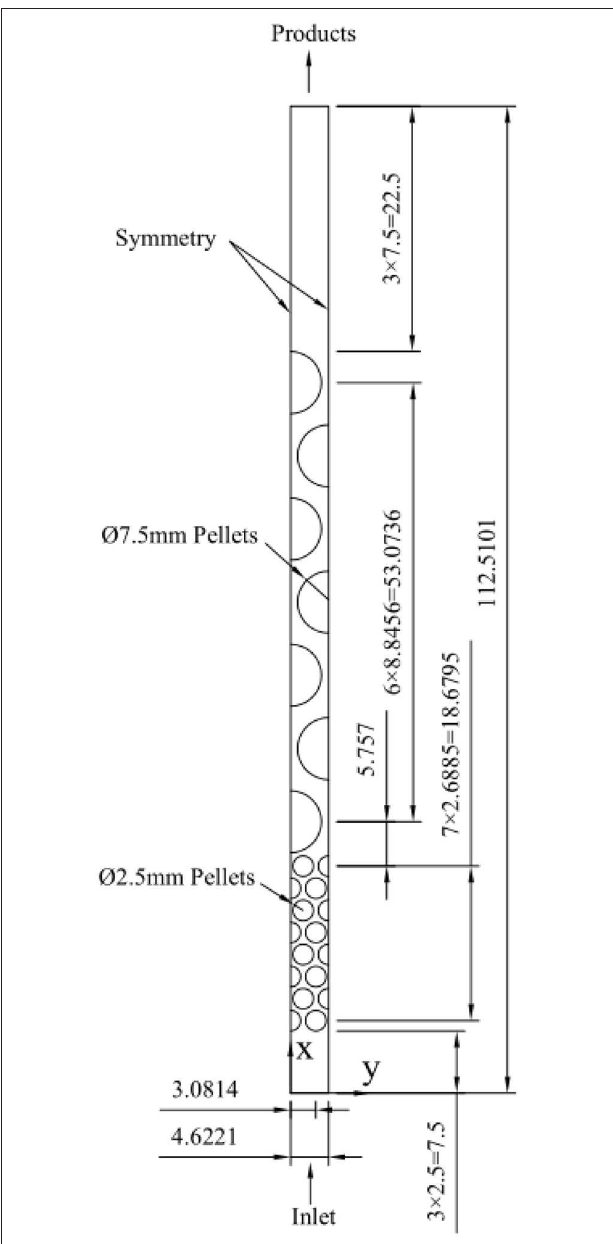
FIGURE 1 | Schematic of the two-layer